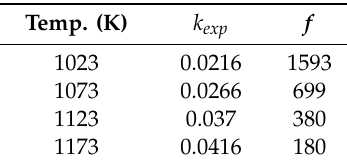
Table 5. Catalytic correction